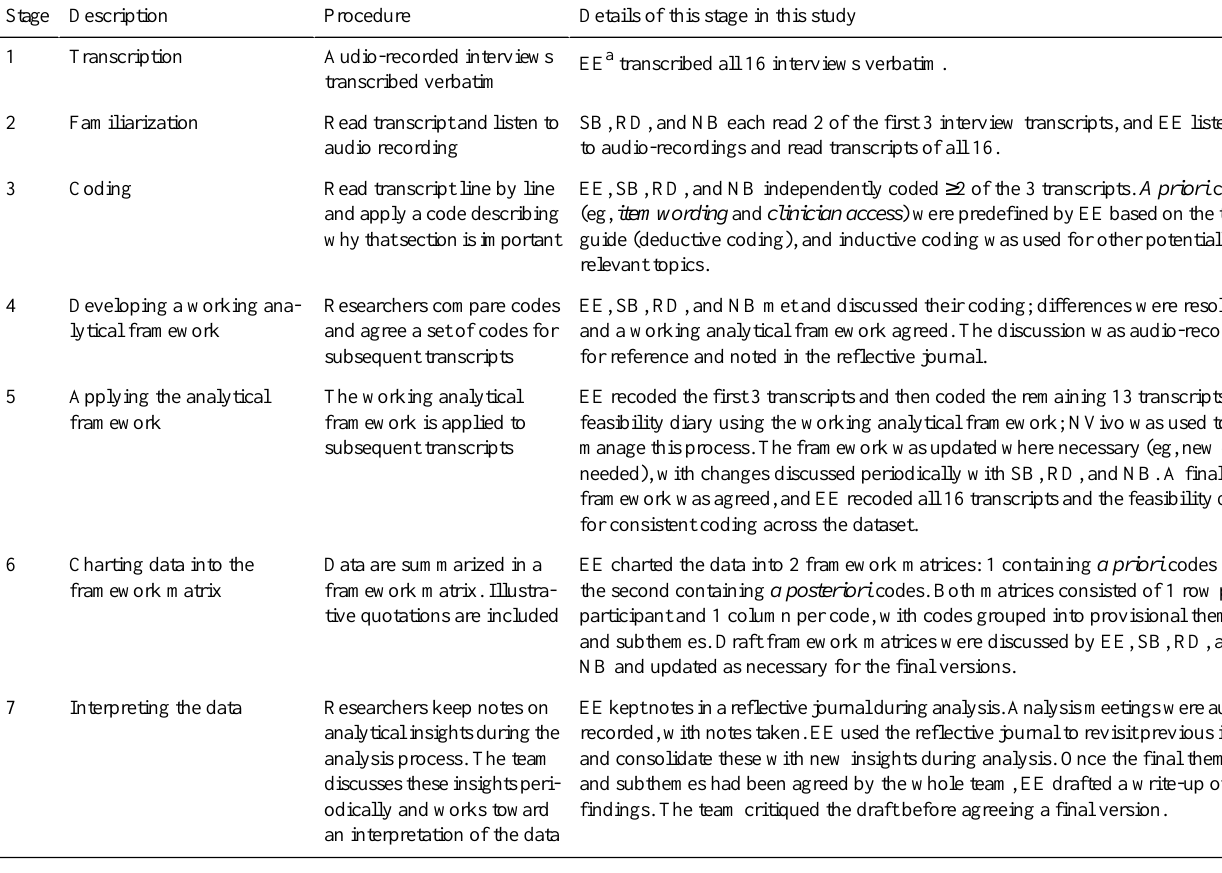
Table 2. Framework analysis method with details regarding its use in this study.